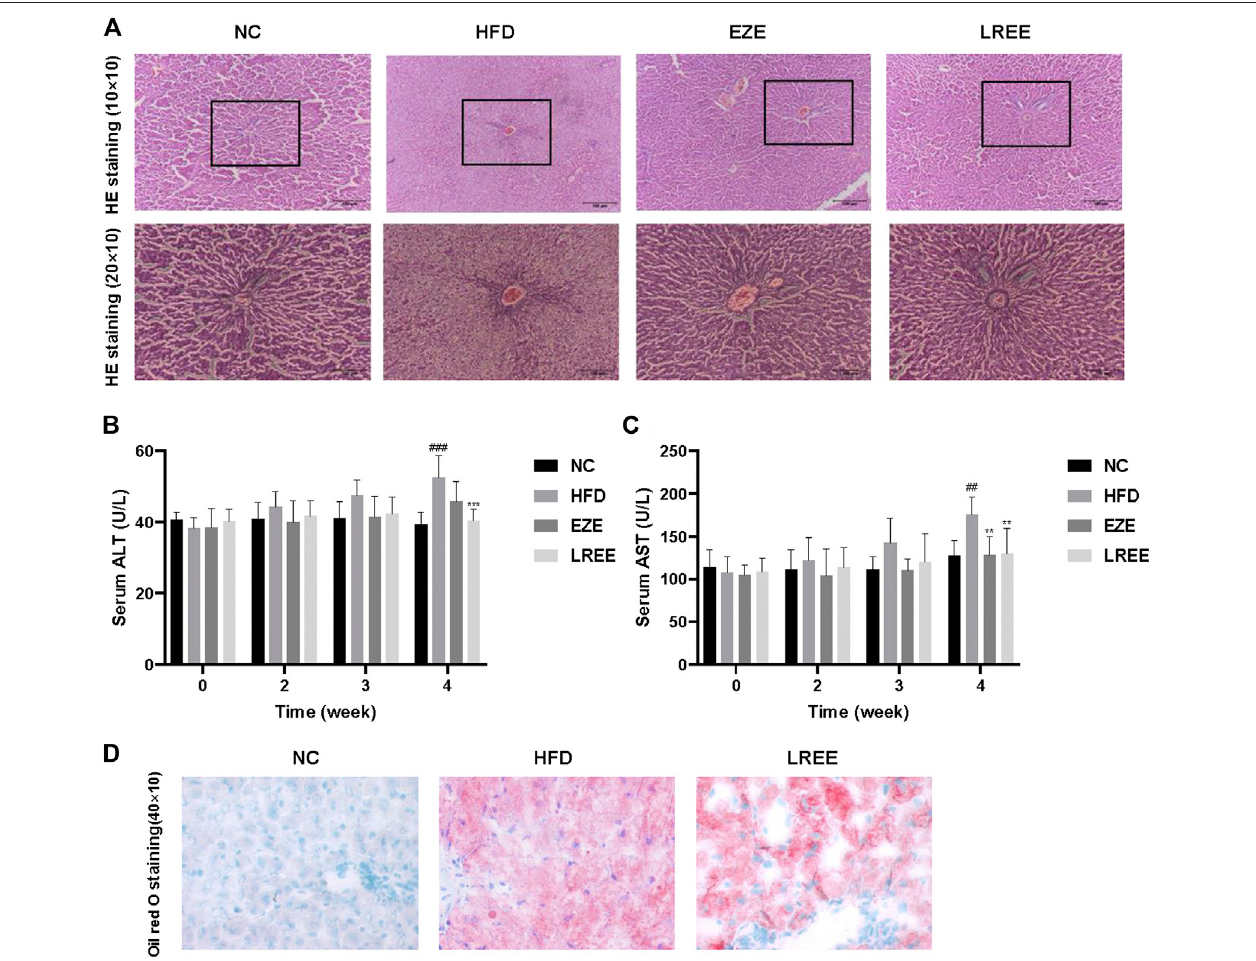
FIGURE 3 | Effects of LREE on HFD-induced liver injury in rats. (A) Representative images of liver histopathology (Hematoxylin and eosin staining). Normal liver tissue structure is complete, hepatocytes are arranged neatly, with uniform size and no steatosis. In the HFD group, the hepatocytes in the liver tissues of rats were disordered, with severe steatosis and a large number of fat vacuoles. Liver tissue structure was intact and fat vacuoles were signi fi cantly reduced in EZE and LREE treatment groups. (B) ALT levels inthe serum. (C) AST levels in the serum. (D) Oil red O staining oflivers from HFD group and LREE group rats. ## p < 0.01, ### p < 0.001 via the NC group; ** p < 0.01, *** p < 0.001 via HFD